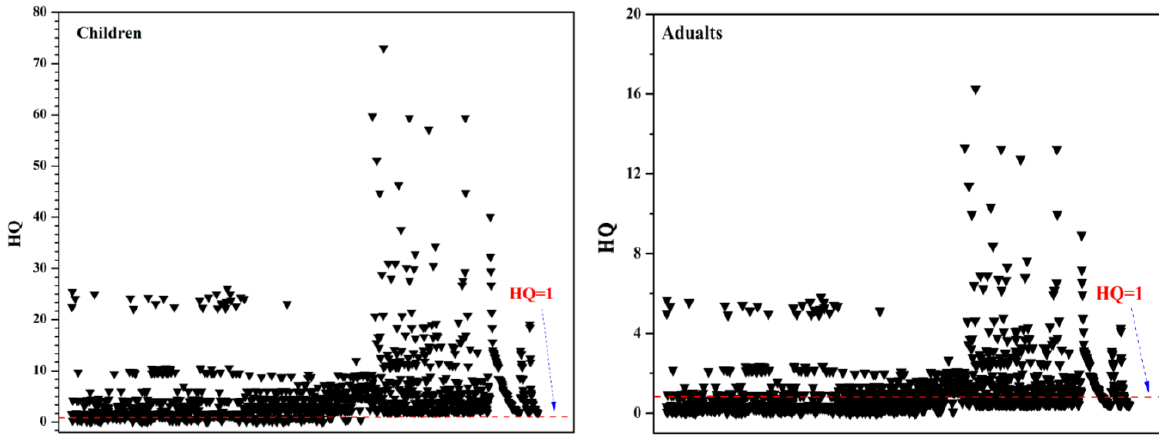
Figure 7. HQs of fluorine to children and Adults.